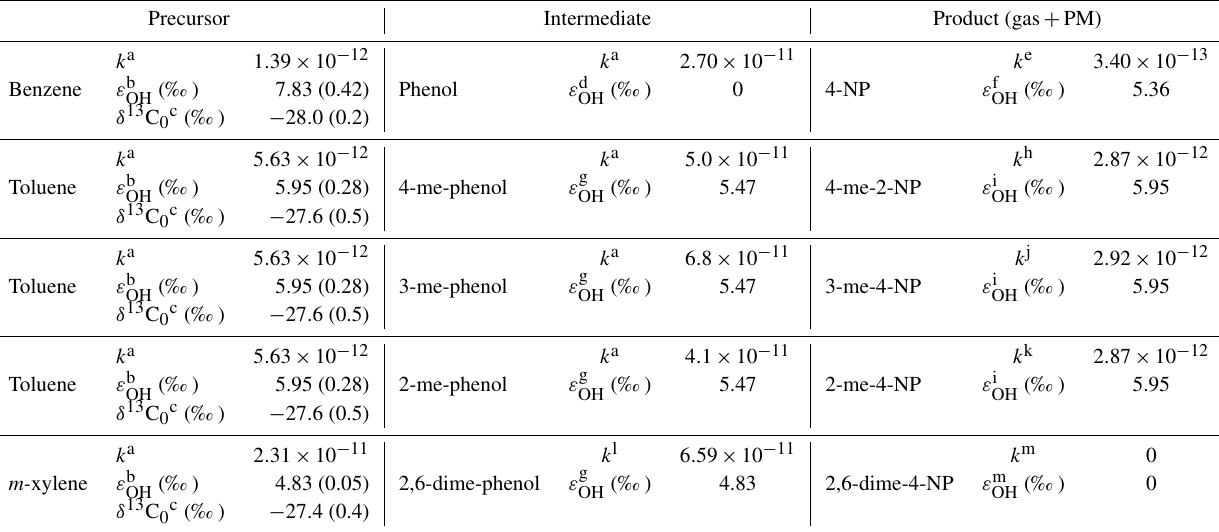
Table 2. Parameters used to determine the PCA for individual products. Units of k (rate constant) are in cm 3 molecules − 1 s − 1 . As 80% of the phenols are in the gas phase (Saccon et al., 2013), the rate constant for the product loss was adjusted to 80% of the gas-phase rate constant. If available, the uncertainty of the parameter is given in